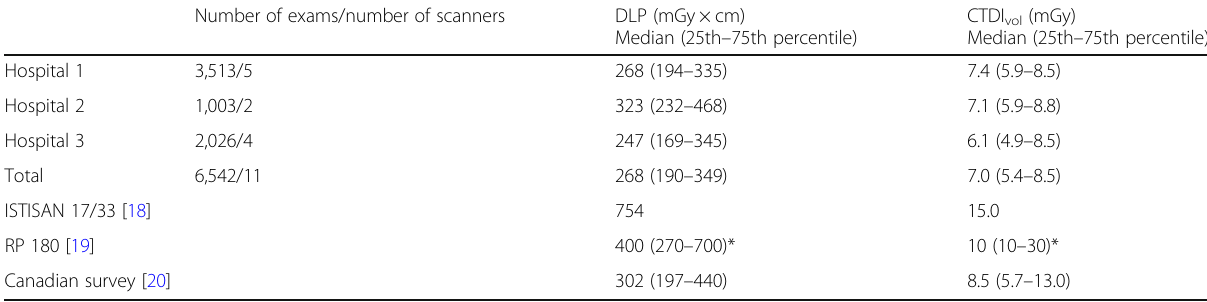
Table 2 Dose-length product (DLP) and volumetric computed tomography dose index (CTDI vol ) for the study common name “ CT Chest WO ” : data from individual hospitals, total and reference